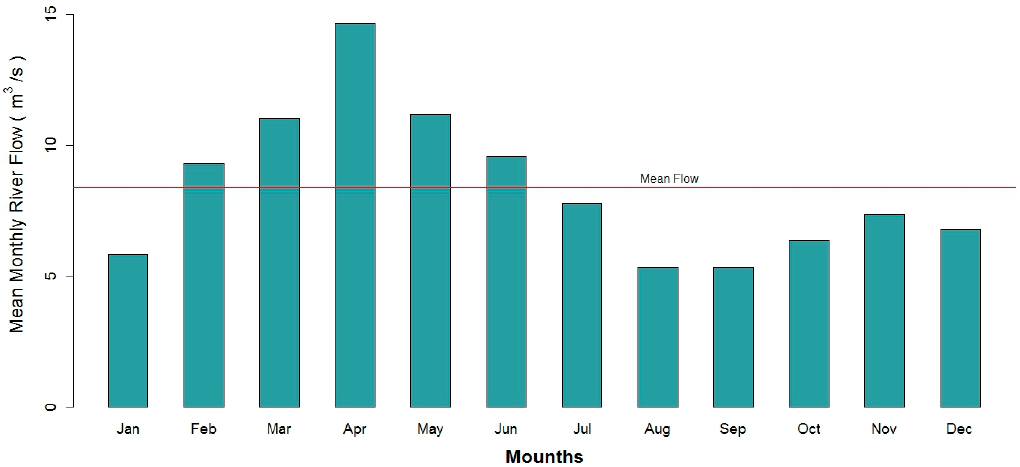
Figure A1. Histogram Machangara River before discharging into Tomebamba River (1964–2010). Water 2017 , 9 , 195